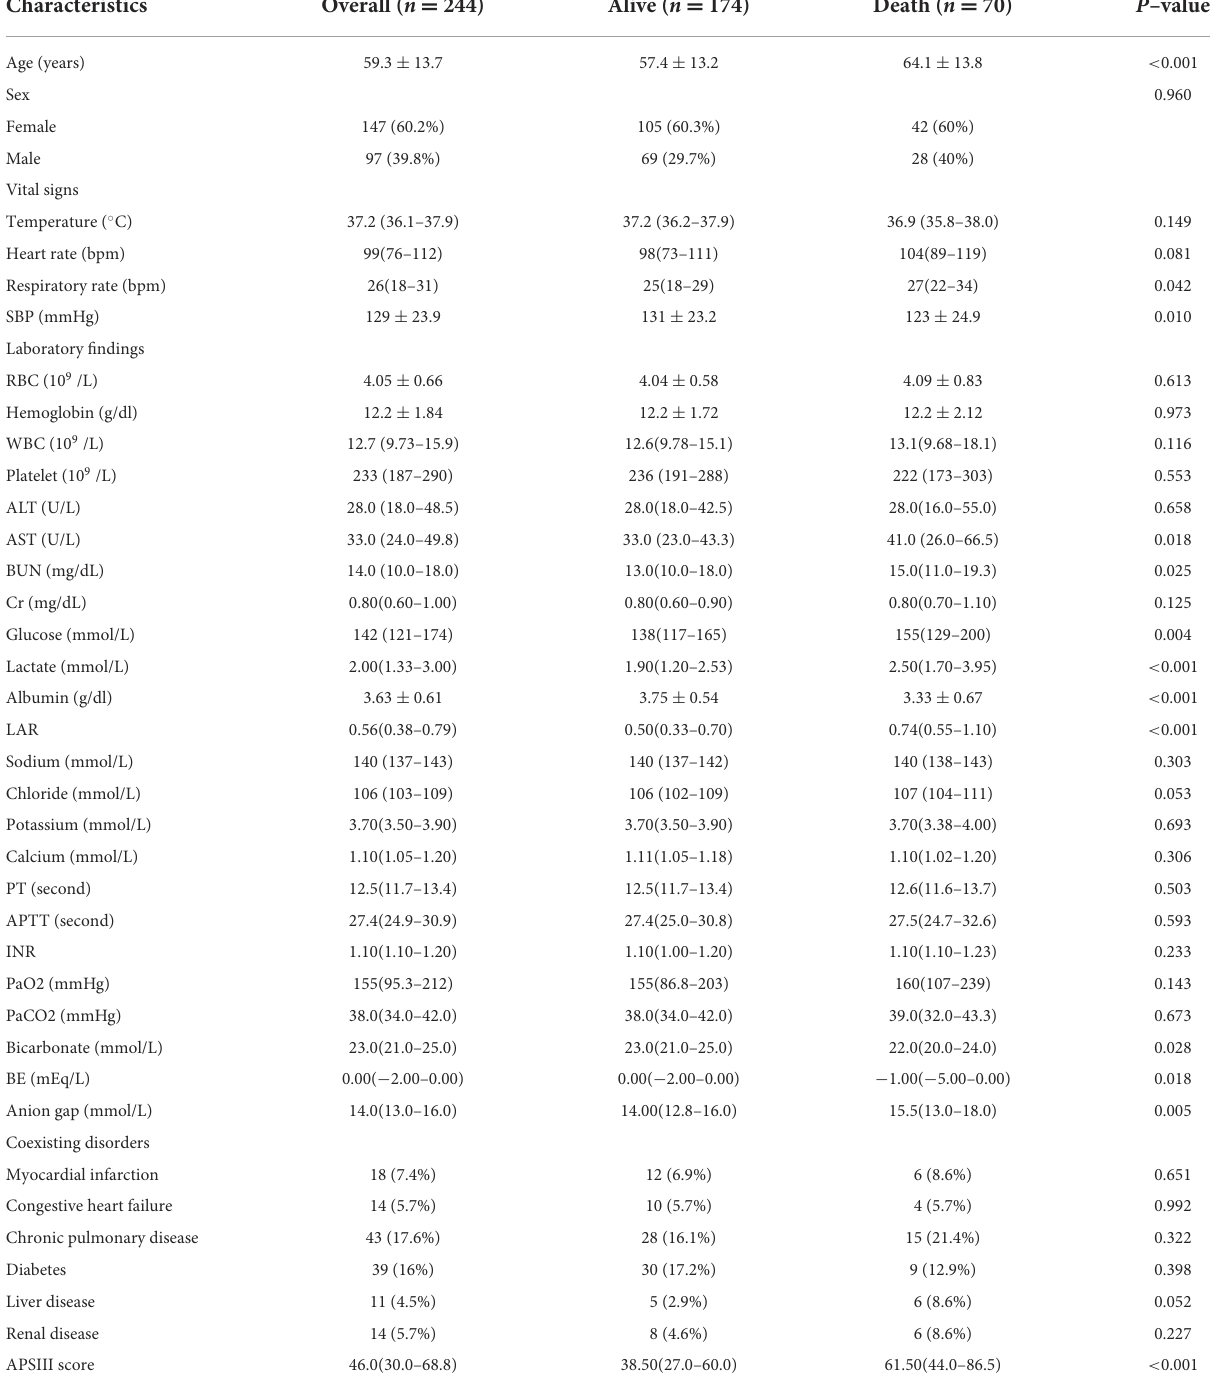
TABLE 1 Demographic and baseline characteristics of study